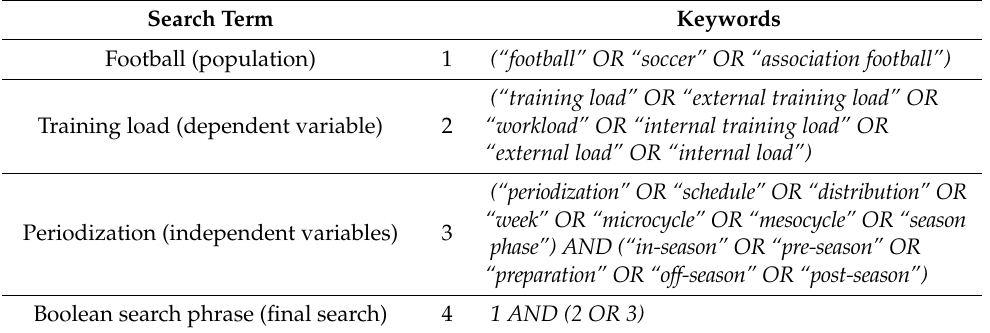
Table 1. Search terms and following keywords for screening